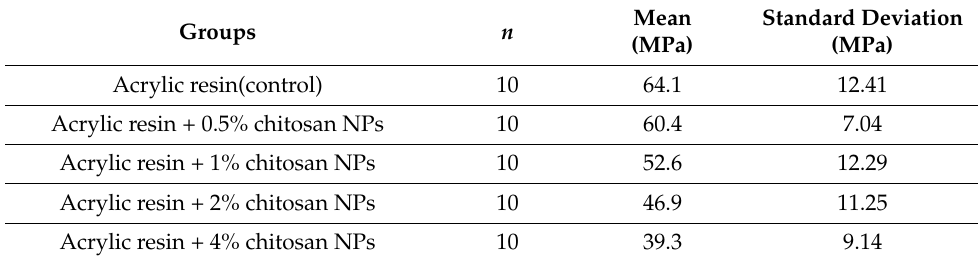
Table 1. Mean and standard deviation of the flexural strength in five different groups ( p < 0.05).